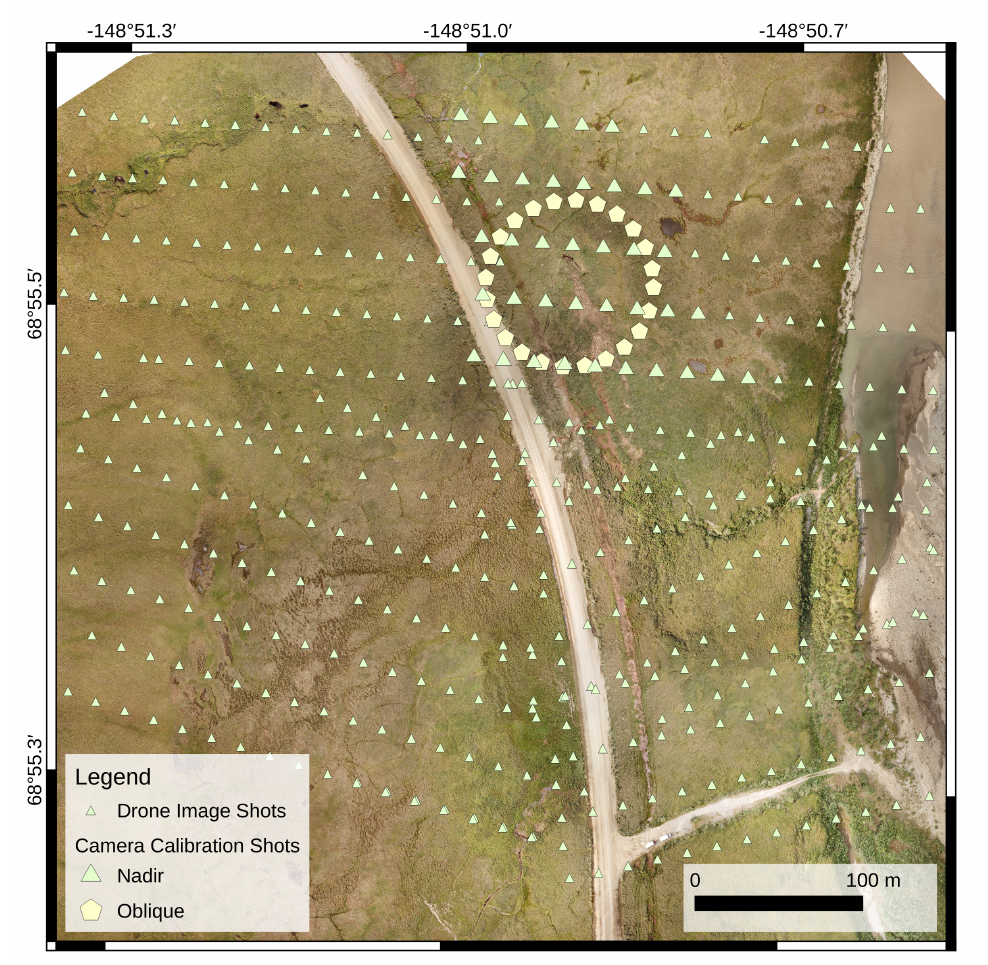
Figure 3. Positions of drone image shots in the study area. Acquisitions were collected at nadir and a height of 80 m a.g.l., with an overlap of 75% along-track and 65% across-track. The circular shape in the upper right corner depicts the drone camera positions during the point of interest flight at a height of 60 m a.g.l. and an image acquisition angle of 45 ◦ . As the point of interest we set the erosion feature. The bigger triangles and pentagons represent the images taken for camera